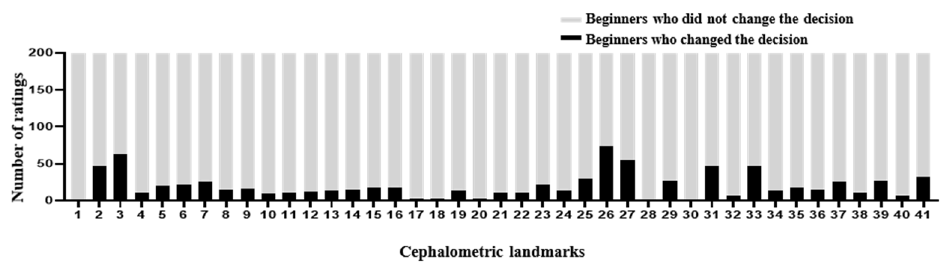
Figure 4. Number of decision changes among beginners across 41 landmarks. In the second experi- ment, the beginners traced the anatomical landmarks on 10 images with the AI’s answer view. The recorded changes are represented as number of ratings. In general, the number of decision changes was small despite being shown at most anatomical